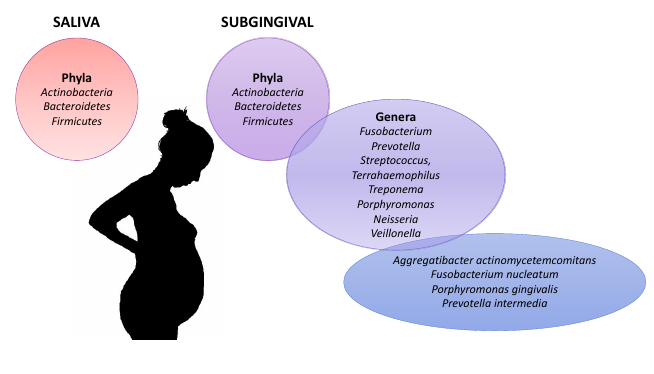
Figure 4. Oral microbiota associated with pregnancy.